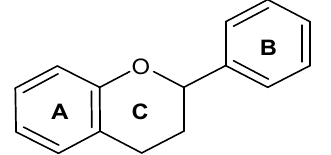
Figure 2. The basic structure of